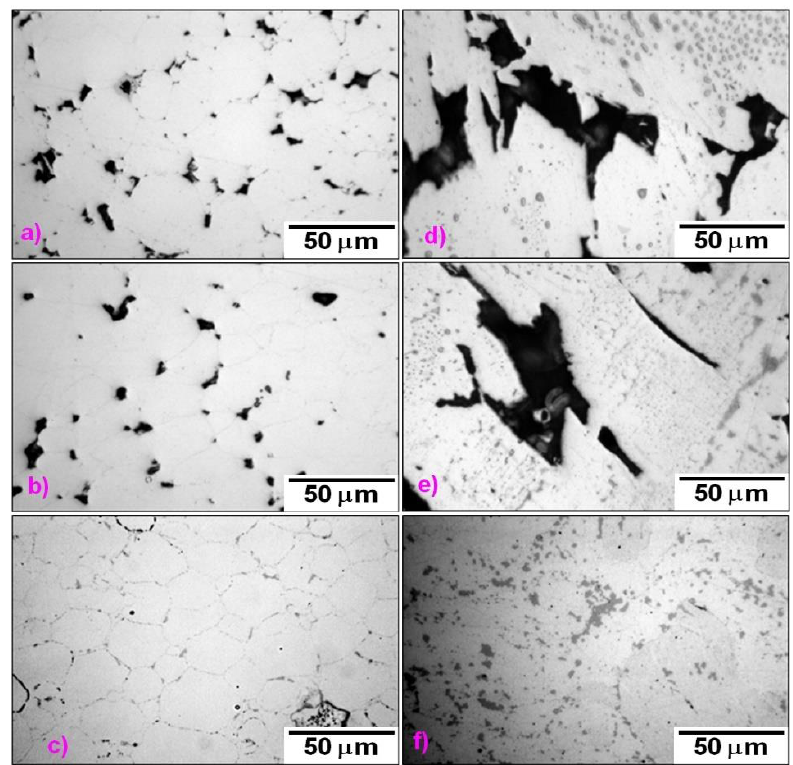
Figure 6. Optical micrographs of SPS compacted Fe28Al from the initial powder sintered at ( a ) 900 °C, ( c ) 1000 °C, and ( e ) 1100 °C and from 1-h milled powder sintered at ( b ) 900 °C, ( d ) 1000 °C, and ( f ) 1100 °C.